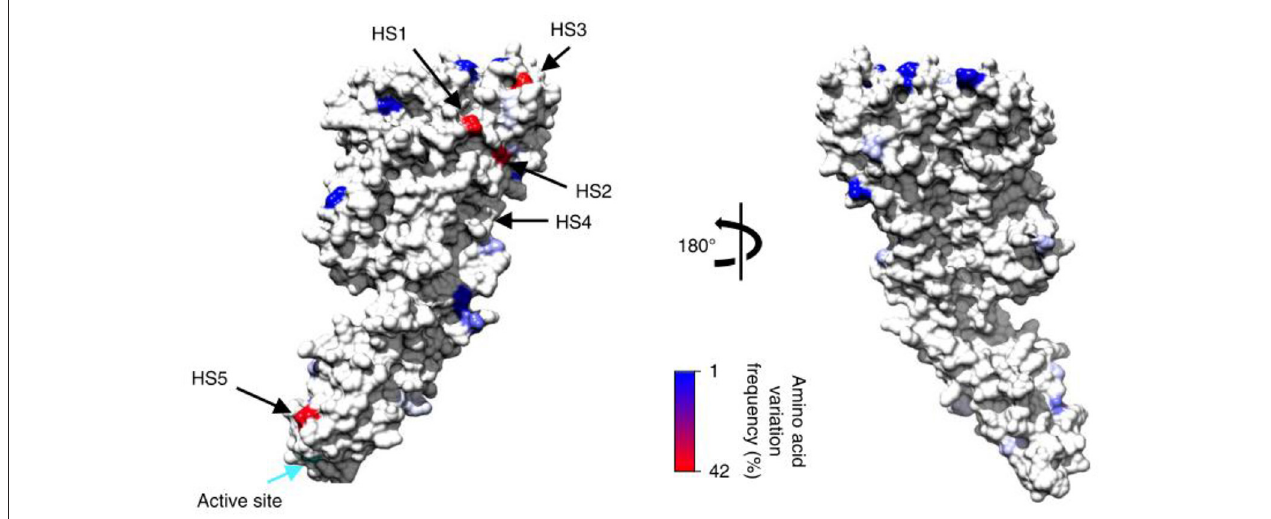
FIGURE 6 | Modeled consensus amino acid sequence and population-derived polymorphisms of the mature streptolysin O protein onto the corresponding crystal structures based on identified polymorphism locations and polymorphism frequencies within GAS genomes for the streptolysin O. Plotted against each structure is the amino acid variation frequency within GAS genomes, as represented in the color gradient from 1% (blue) to 42% variable (red); invariant sites are colored light gray. The positions of the top five most variable surface hot spots (HS) are annotated. Active sites for each enzyme are also indicated (cyan arrow)